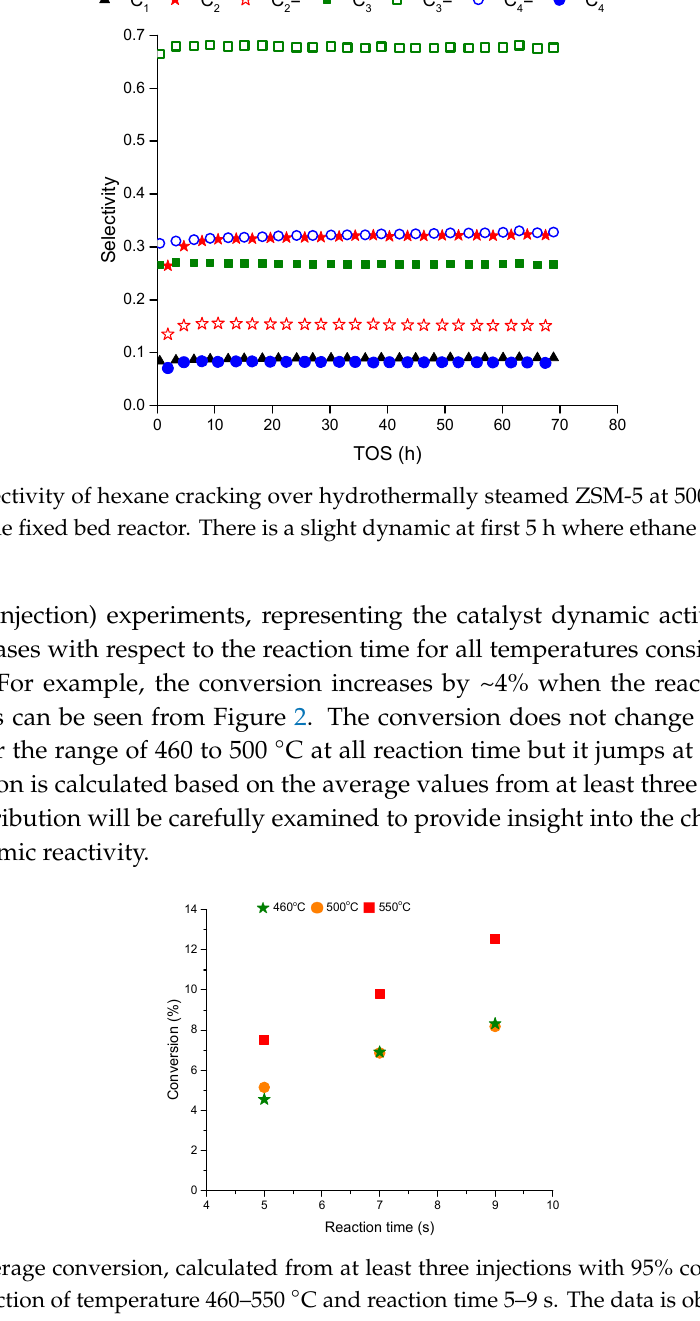
Figure 3. Average C 3 = / C 3 and Olefin / Paraffin (O/P) ratios, calculated from three injections with 95% confidence of ±0.03, as a function of temperature 460–550 °C and reaction time 5–9 s. O/P presented in the figure with white fill, shifted to the right for better clarity. The C 3 = / C 3 is represented by filled shape. The data is obtained from the riser simulator.